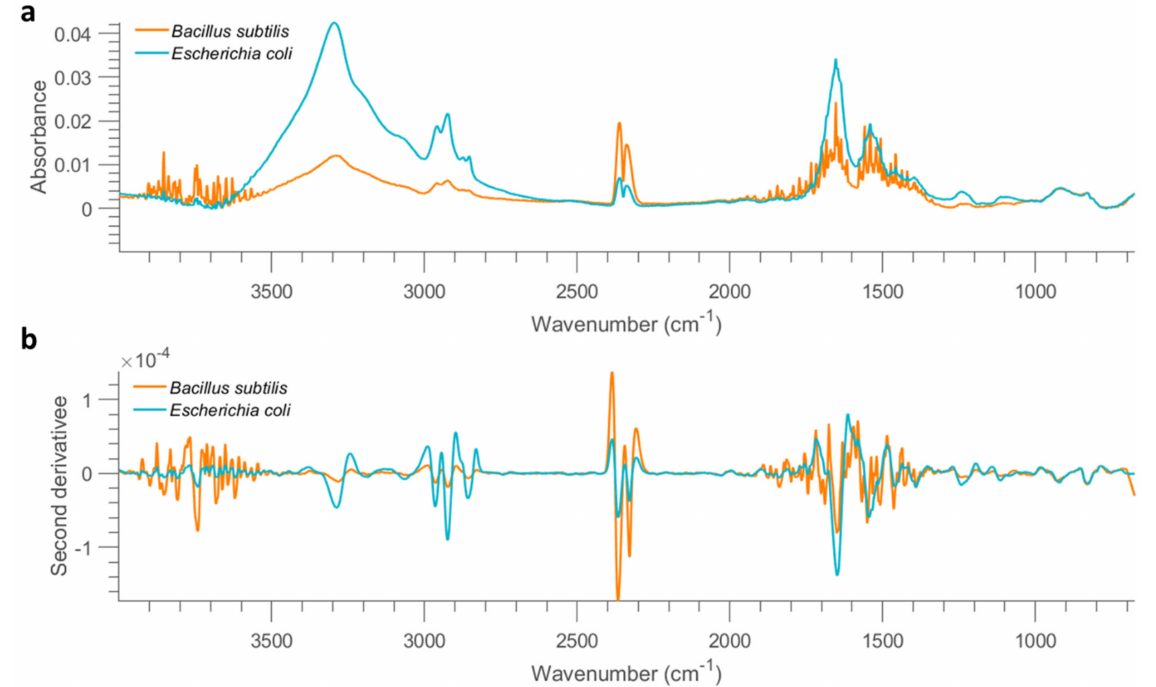
Figure 2. Mean FTIR (after applying asymmetric least squares smoothing to remove baseline) spectra of all bacterial cells from the concentration of 10 OD deposited on mirror aluminium slide ( a ) and the result after performing second derivative ( b